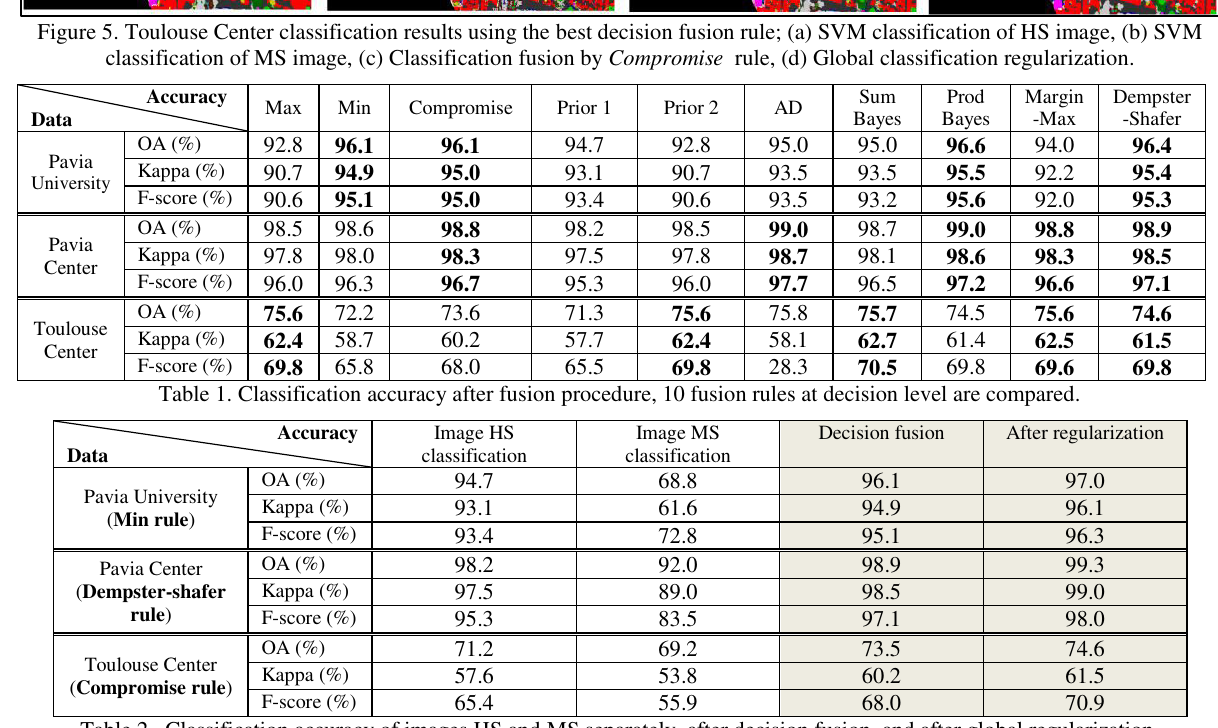
Table 2. Classification accuracy of images HS and MS separately, after decision fusion, and after global